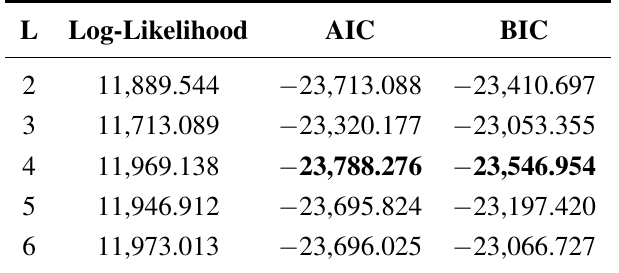
Table 2. Log-likelihood values, Akaike (AIC) and Schwarz (BIC) information criteria of the proposed Student- t MS model with different number of components. Bold face indicates the selected